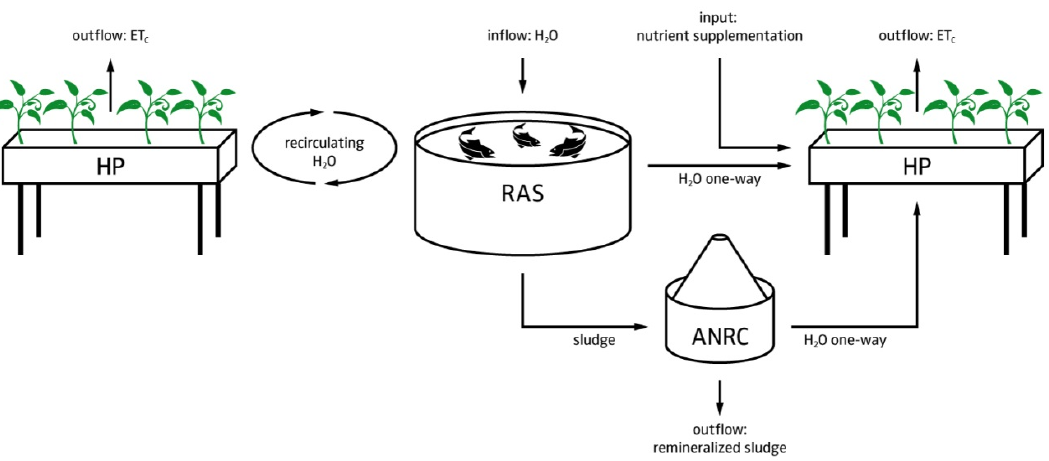
Figure 20. The hybrid decoupled system is a combination of the one ‐ loop and the decoupled approach. Whereas the one ‐ loop aquaponic system is regulating the nitrate of the RAS system, the decoupled hydroponic part utilizes the recycled nutrients from the ANRC. Especially for systems that focus on fish production, their advantage is that no denitrification, and thus no waste of nitrate is required.